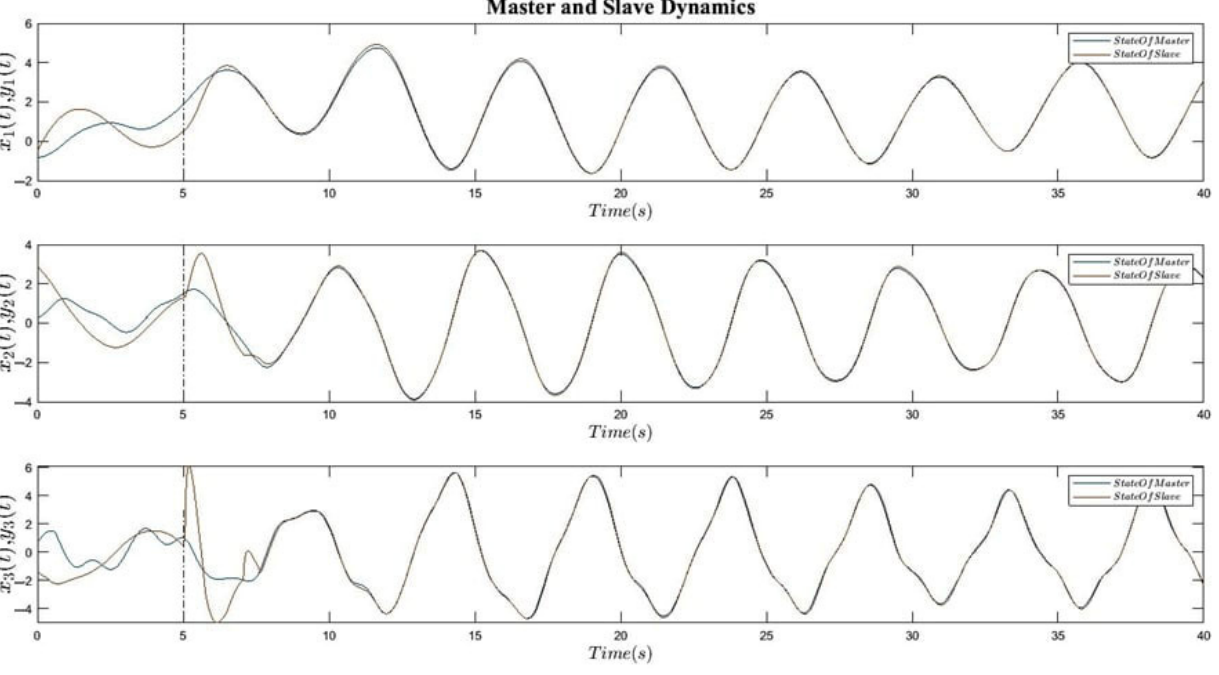
Figure 3. Synchronization of jerk systems using the proposed mechanism and applying the control signal at t = 5 s.